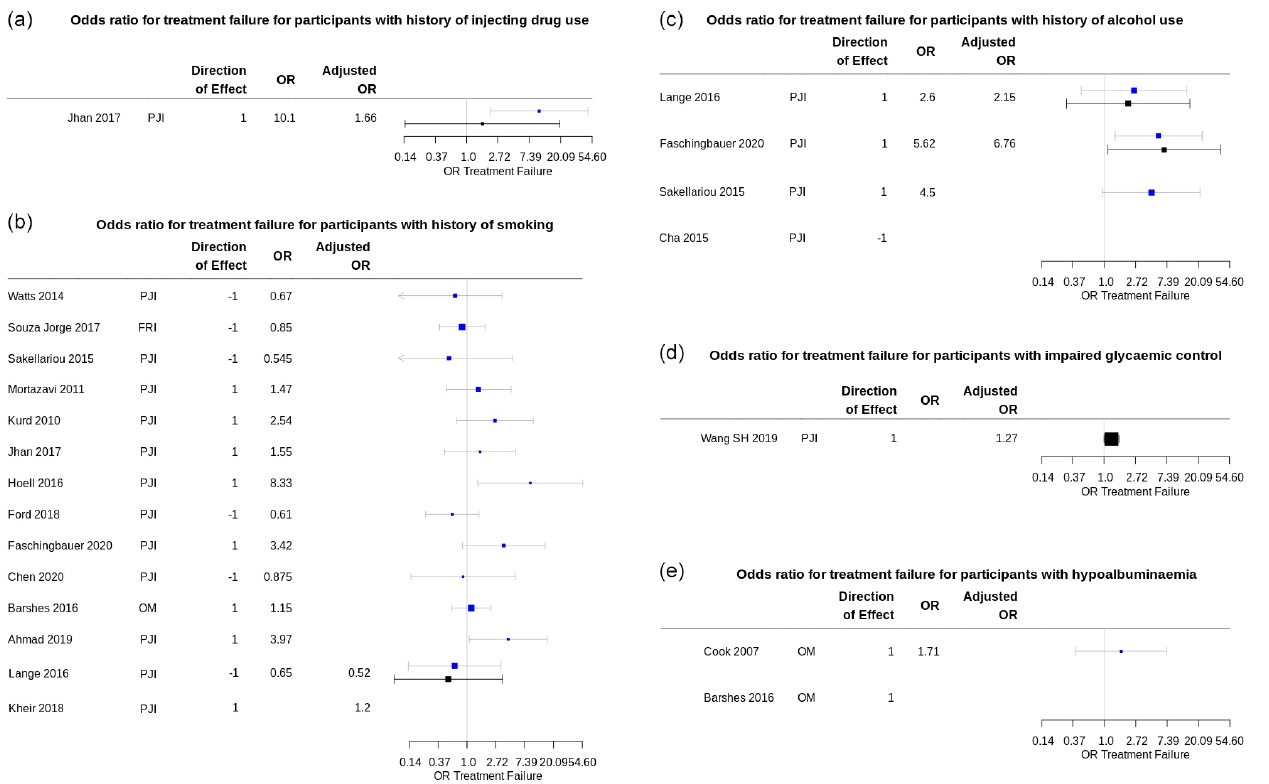
Figure 3. Summary plots of the odds ratio (OR) for treatment failure in participants with a modifiable risk factor of interest reported in included prognostic studies. Univariable ORs are shown in blue; multivariable (adjusted) ORs are shown in black. Plots produced using package forestplot for R (Gordon, 2020). (a) Univariable and adjusted ORs for treatment failure for participants with a history of injecting drug use. The adjusted OR from Jhan et al. (2017) is for Cox proportional hazard regression analysis for treatment failure, adjusted for BMI, liver cirrhosis, microbiology investigations, the presence of a sinus tract, repeated surgical debridement, and operating time > 4h. (b) Univariable and adjusted OR for treatment failure for participants with a history of smoking. Adjusted OR from Lange et al. (2016) is for treatment failure at 12 months in all study participants, adjusted for age, sex, American Society for Anaesthesiology (ASA) score, diagnosis of diabetes mellitus, BMI, and alcohol use, using logistic regression modelling from the published data. Confidence intervals for adjusted OR in Kheir et al. (2018), calculated from the risk prediction model-scoring equation, were not reported. (c) Univariable and adjusted ORs for treatment failure for participants with a history of alcohol use or dependence. Adjusted OR from Lange et al. (2016) is for treatment failure at 12 months in all study participants, adjusted for age, sex, ASA score, diagnosis of diabetes mellitus, BMI, and smoking, using logistic regression modelling from the published data. Adjusted OR from Faschingbauer et al. (2020) was adjusted for surgical approach (two-stage revision), additional revision between first- and second-stage surgery, and number of prior surgical procedures. (d) Adjusted OR for peri- operative blood glucose variability reported in S. H. Wang et al. (2019) was adjusted for “all confounders”, which is understood to include age, sex, BMI, joint involvement, Charlson comorbidity index, diagnosis of diabetes mellitus, rheumatic disease, index surgery (primary or revision), debridement and irrigation before spacer placement, and spacer exchange, as reported in the study methods. (e) Univariable OR for treatment failure for participants with hypoalbuminemia (serum albumin 2.2 to 3.0gL − 1 ) reported in Cook et al.